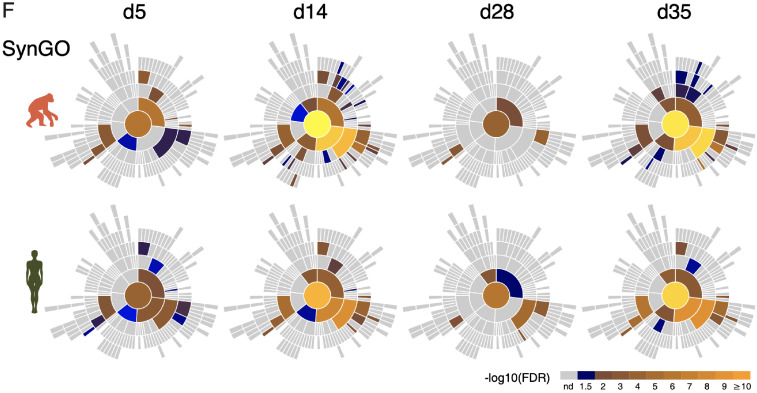
scRNAseq analysis of synaptic maturation in ape and human iNs.F. Sunburst plots of enriched synaptic GO terms in developing ape (top) and human (bottom) iNs with higher expressed genes conserved in developing ape and human iNs sub-clusters at each time point. Bottom, the log10-transformed FDR-corrected p value per ontology term is visualized for BP. Note that the bottom BP sunburst plots are aligned with the top-right one.